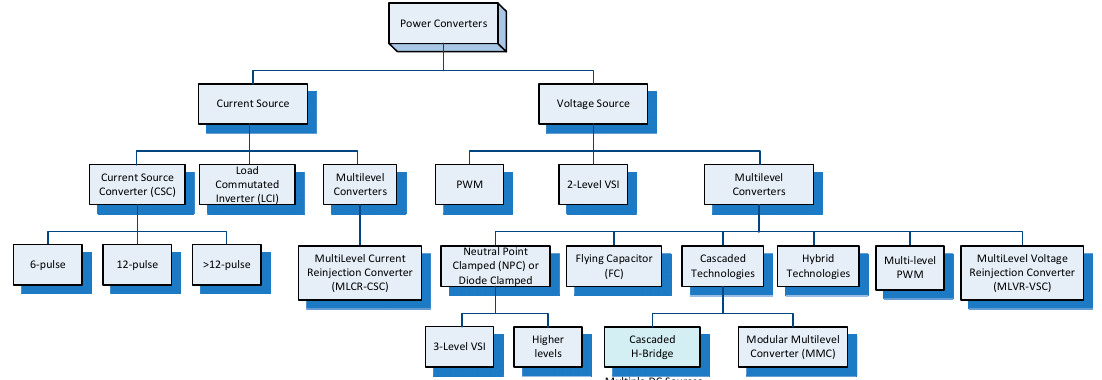
/ Direct Current (DC) Converter Figure 1. Alternating Current (AC)/Direct Current (DC) Converter classification. Figure 1. Alternating Current (AC)